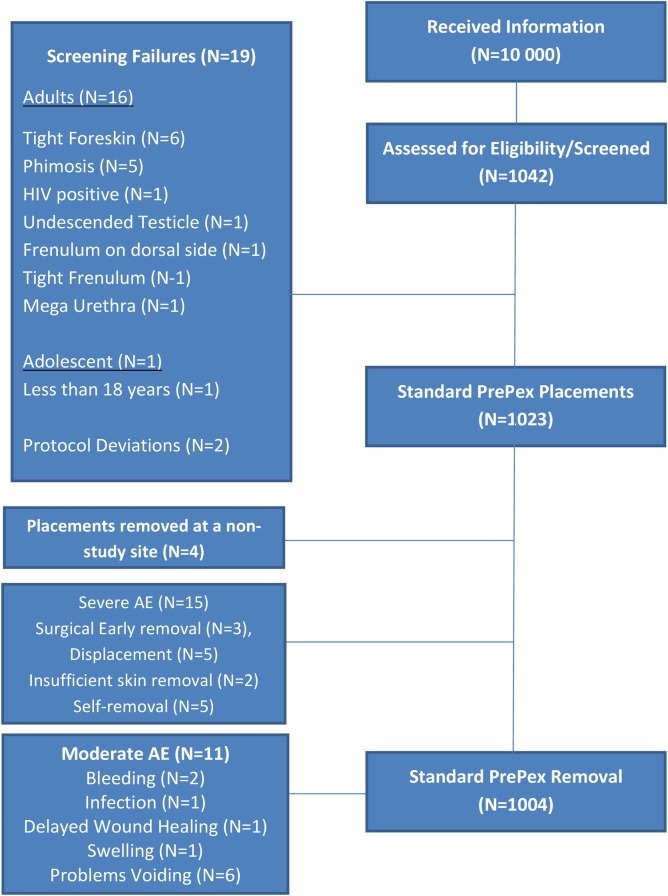
PrePex flowchart.